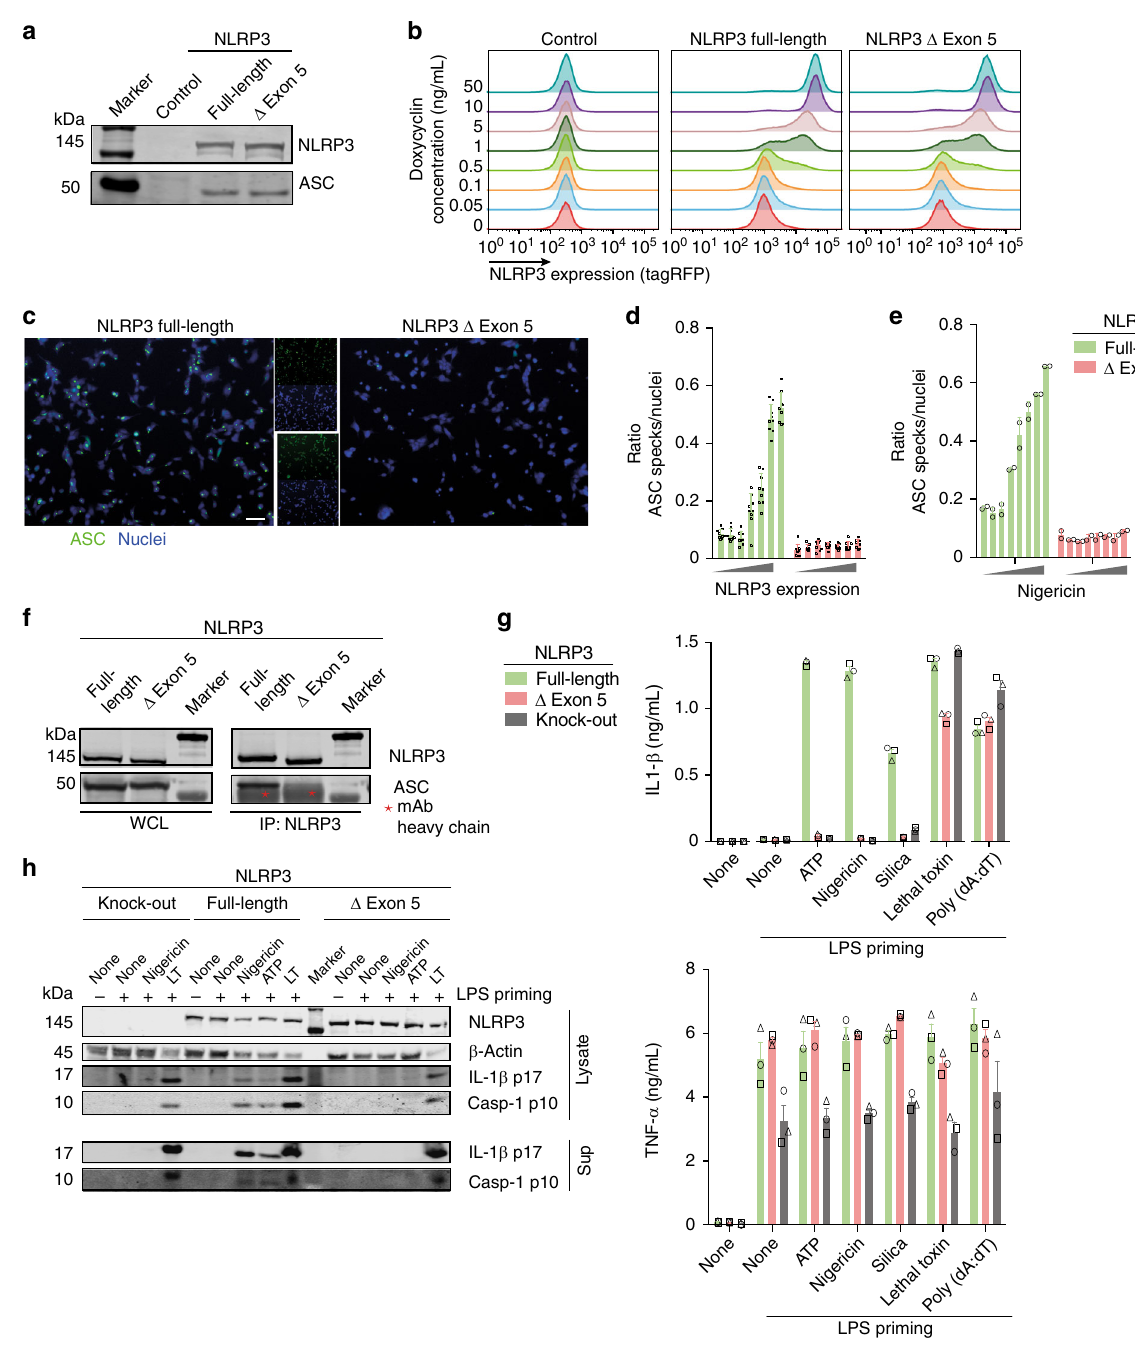
Fig. 4 NLRP3 Δ exon 5 is inactive. a Immunoblot expression control of NLRP3-tagRFP and ASC-mCerulean from HEK TREx Flp-In cells. b NLRP3-tagRFP was induced in HEK TREx with the respective concentrations of doxycycline. Expression levels were measured by FACS. c HEK TREx cells expressing inducible NLRP3-tagRFP and ASC-mCerulean were analyzed for ASC speck formation by fl uorescence microscopy. Cell nuclei were counterstained with Draq5. Scale bar represents 50 μ m. d Quanti fi cation of ASC speck formation after doxycycline induced NLRP3 overexpression (0 – 10 ng/mL). Mean and SD of nine frames per condition. Overlaid symbols represent single measurements. e Quanti fi cation of ASC speck formation after 2.5 h stimulation with nigericin (0 – 10 µ M). Mean and SD of technical duplicates, nine frames per well, representative of three independent experiments. Overlaid symbols represent single measurements. f Co-immunprecipitation (IP) of ASC with NLRP3-tagRFP from HEK TREx Flp-In cells. NLRP3 was immunprecipitated using anti-tagRFP mAb. Asterisk indicates heavy band of IP mAb. Representative of two independent experiments. g and h NLRP3-de fi cient immortalized macrophages (iMos) were retrovirally reconstituted with either NLRP3 full-length or NLRP3 Δ exon 5. g Cytokine secretion after priming with LPS (TNF) and activation of the NLRP3, NLRP1b, or AIM2 in fl ammasomes (IL-1 β ). Mean and SD of technical triplicates, representative of three independent experiments. Each individual data point from one experiment is plotted using a unique overlaid symbol shape. h Immunoblots of iMos after activation of the NLRP3 in fl ammasome (ATP, nigericin) or the NLRP1b in fl ammasome (lethal toxin). Blots are representative of two independent experiments. See also Supplementary Fig. 4. Source data are provided as a Source Data fi